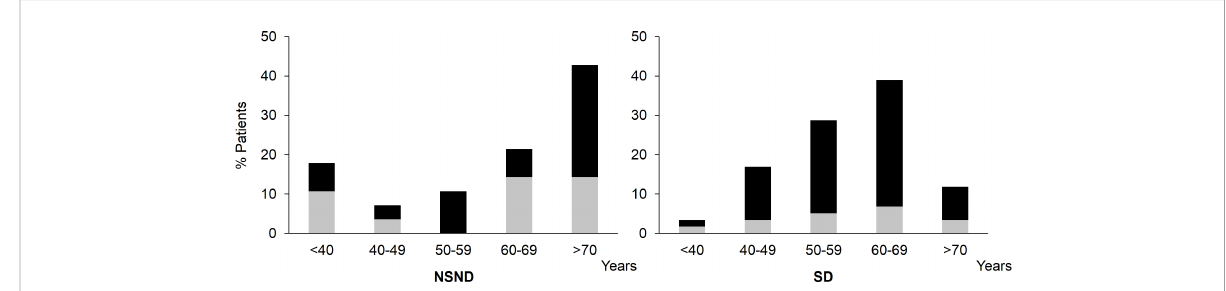
FIGURE 1 Age and gender distribution of NSND and SD OSCC patients depending on their risk factors. □ : female, ■ : male; OSCC, Oral Squamous Cell Carcinoma; NSND, Non-Smoker/Non-Drinker; SD,